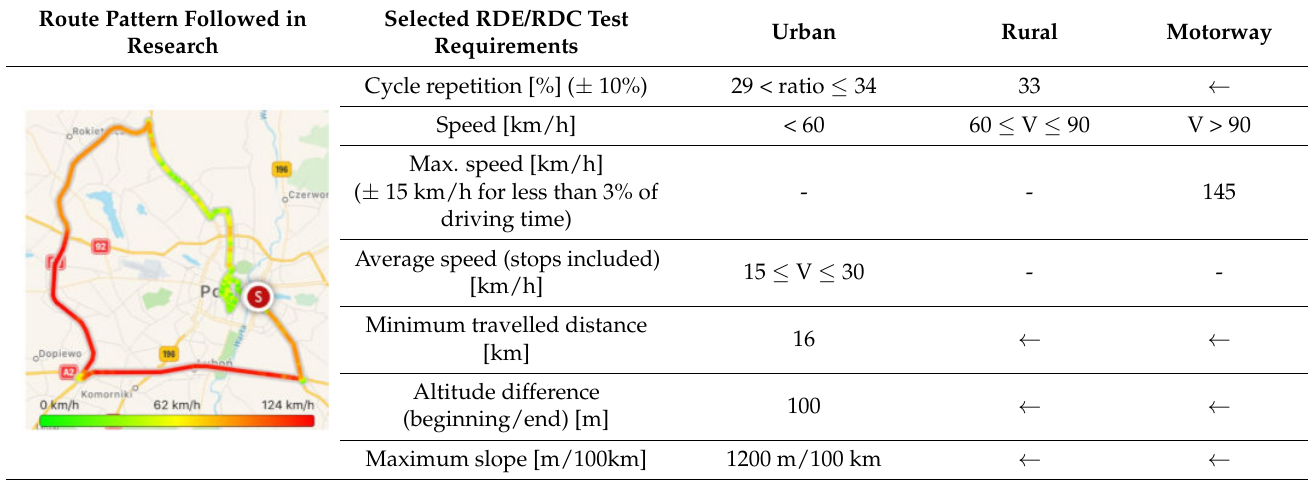
Table 2. Real driving conditions test requirements with map of the route traveled during the measurements [34]. Route Pattern Followed